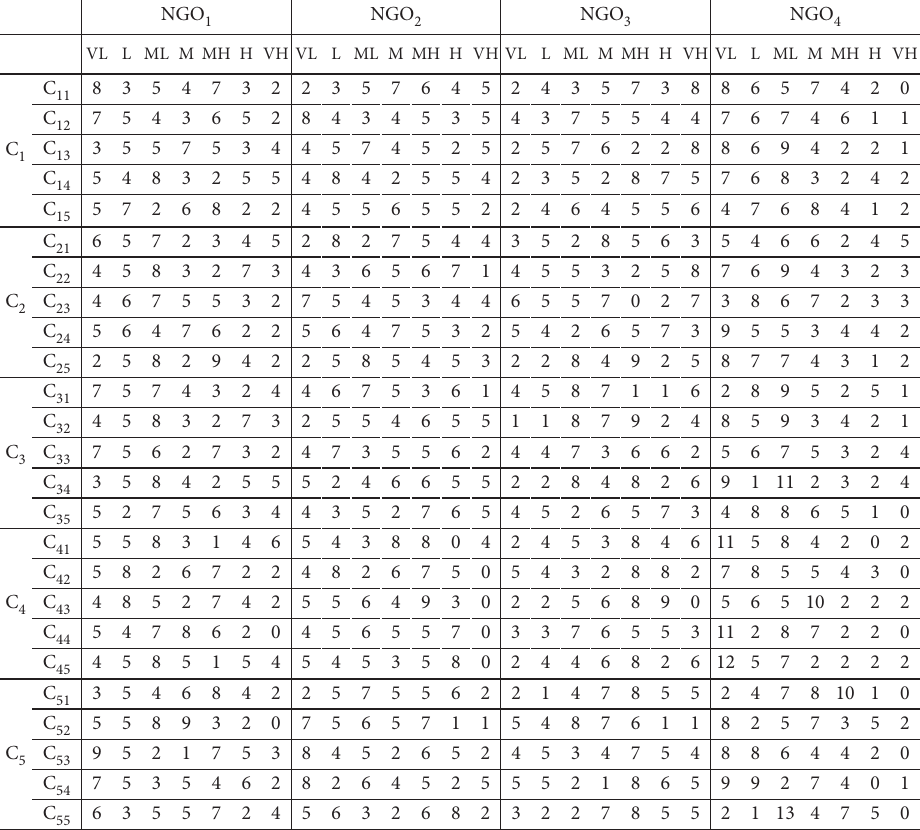
Table 6. Expert evaluation scores of the NGOs alternatives NGO 1 NGO 2 NGO 3 NGO